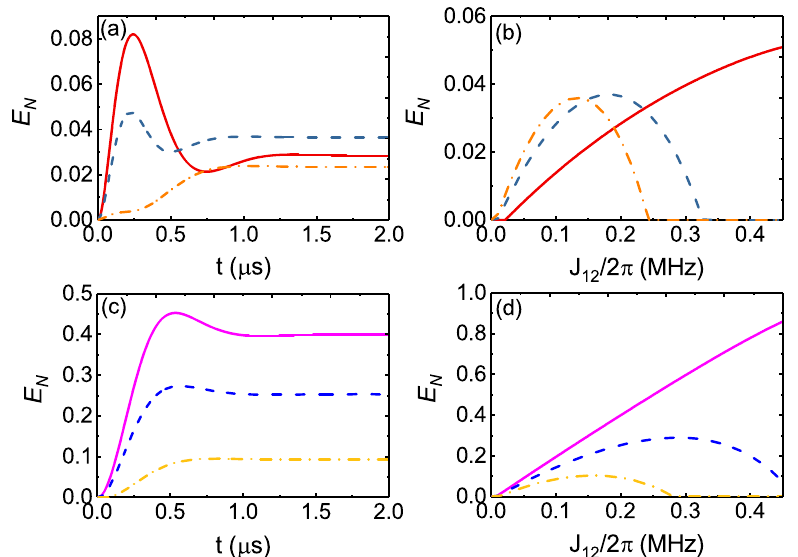
Figure 3. Logarithmic negativity E N affected by the phase difference φ . ( a ) Time evolution of the logarithmic negativity E N between the cavity modes a 1 and a 2 with J 12 /2 π = 0.2 MHz for φ = 0, π /2, and π . ( b ) Stationary logarithmic negativity E N between the cavity modes a 1 and a 2 as a function of J 12 /2 π for φ = 0, π /2, and π . ( c ) Time evolution of the logarithmic negativity E N between the mechanical modes b 1 and b 2 with J 12 /2 π = 0.2 MHz for φ = 0, φ = π /2, and φ = π . ( d ) Stationary logarithmic negativity E N between the mechanical modes b 1 and b 2 as a function of J 12 /2 π for φ = 0, π /2, and π . Here, φ = 0, π /2, π correspond to the solid line, dashed line, and dash-dotted line, respectively. Other parameters are the same as Figure 2, except G 22 /2 π = 1 MHz. Here, we keep J 21 = J 12 .